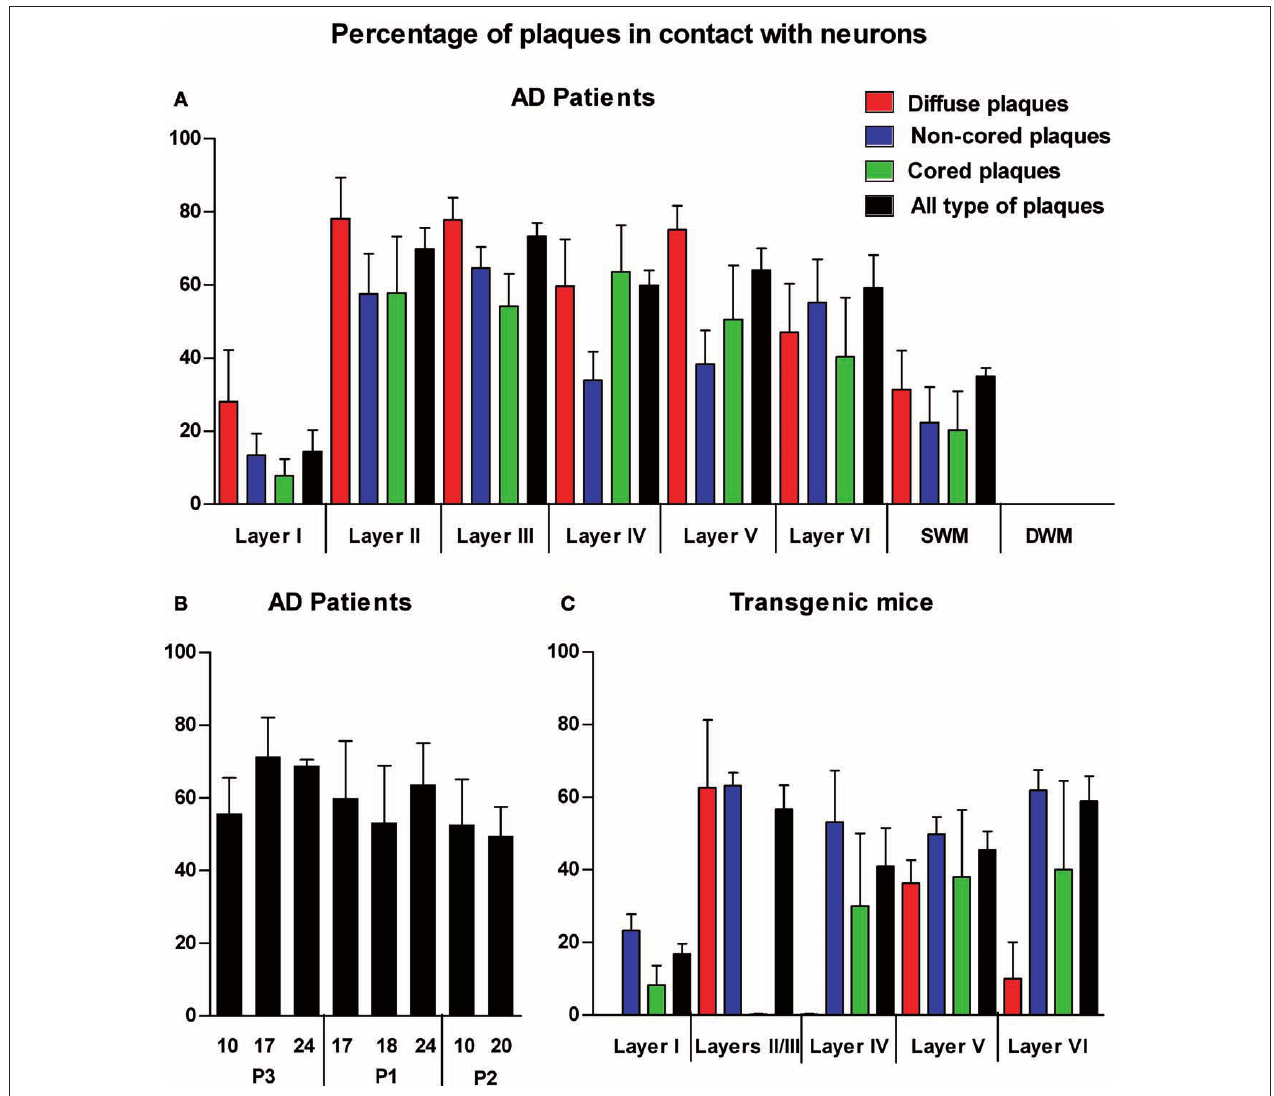
FIGURE 5 | (A) Bar diagram illustrating the percentage of the different types of plaques (diffuse, non-cored neuritic, and cored neuritic) in contact with neurons by cortical layers in the neocortex of AD patients. (B) Bar diagram illustrating the percentage of plaques (all types) in contact with neurons in different cortical